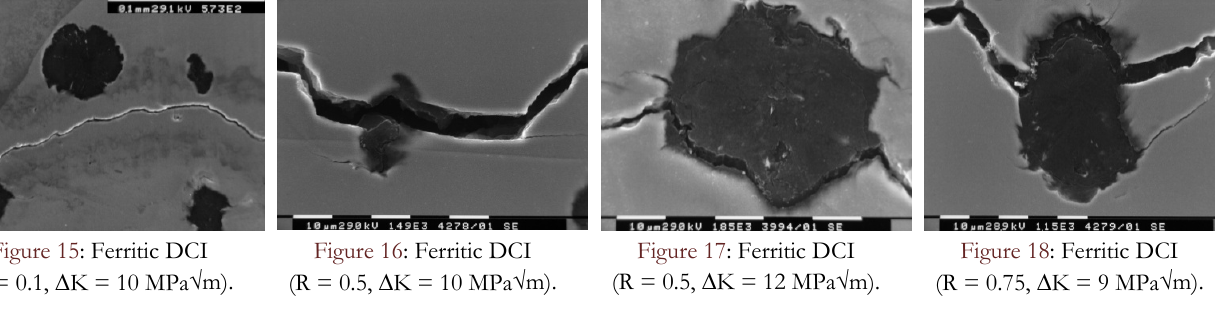
Figure 16: Ferritic DCI (R = 0.5,  K = 10 MPa √ m).